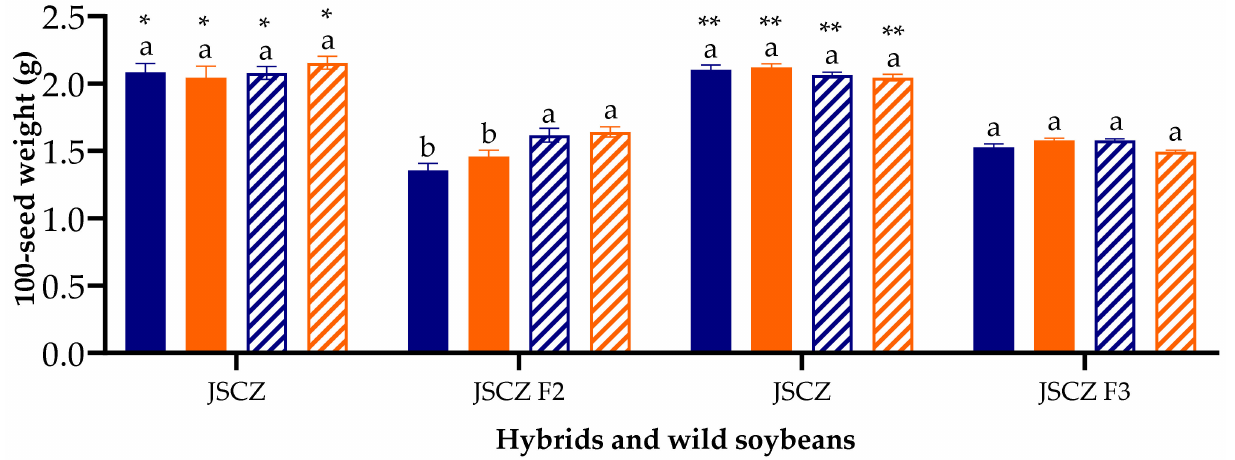
Figure 7. The 100-seed weight of hybrids’ seeds and wild soybean seeds under four planting conditions. Note: * and ** indicate significant difference ( p < 0.05) and extremely significant difference ( p < 0.01) of the same trait between hybrids and their wild soybeans. Different lowercase letters indicate significant difference ( p < 0.05) of hybrids or wild soybeans among four planting conditions.